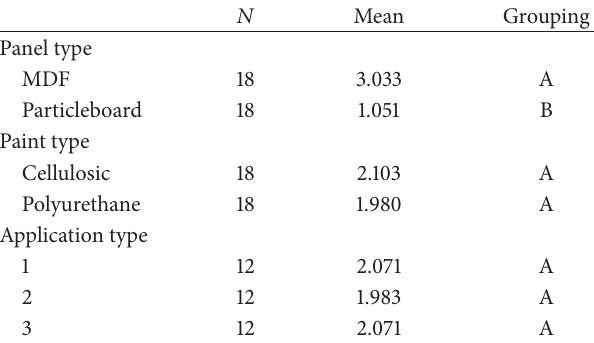
Table 5: Grouping analysis based on Tukey’s test of adhesion resistance of the samples as a function of types of panel, paints, and